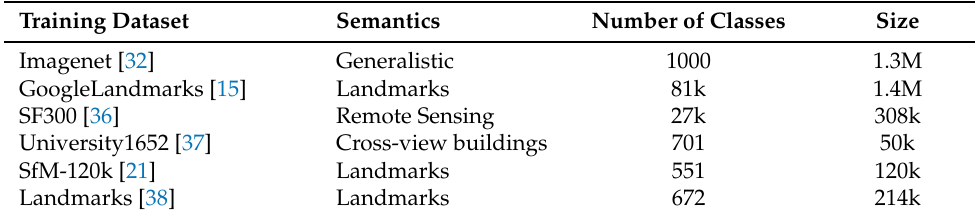
Table 2. Overview of available training